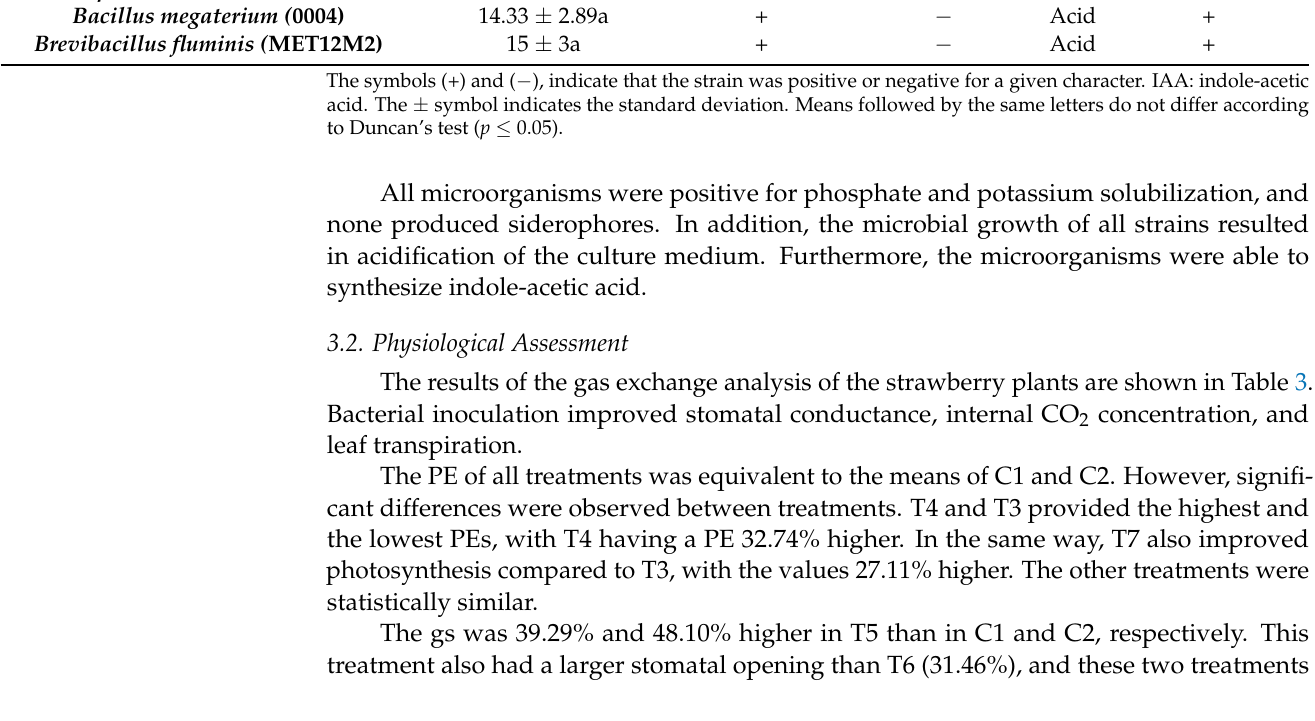
Potassium Siderophore pH IAA Solubilization Production